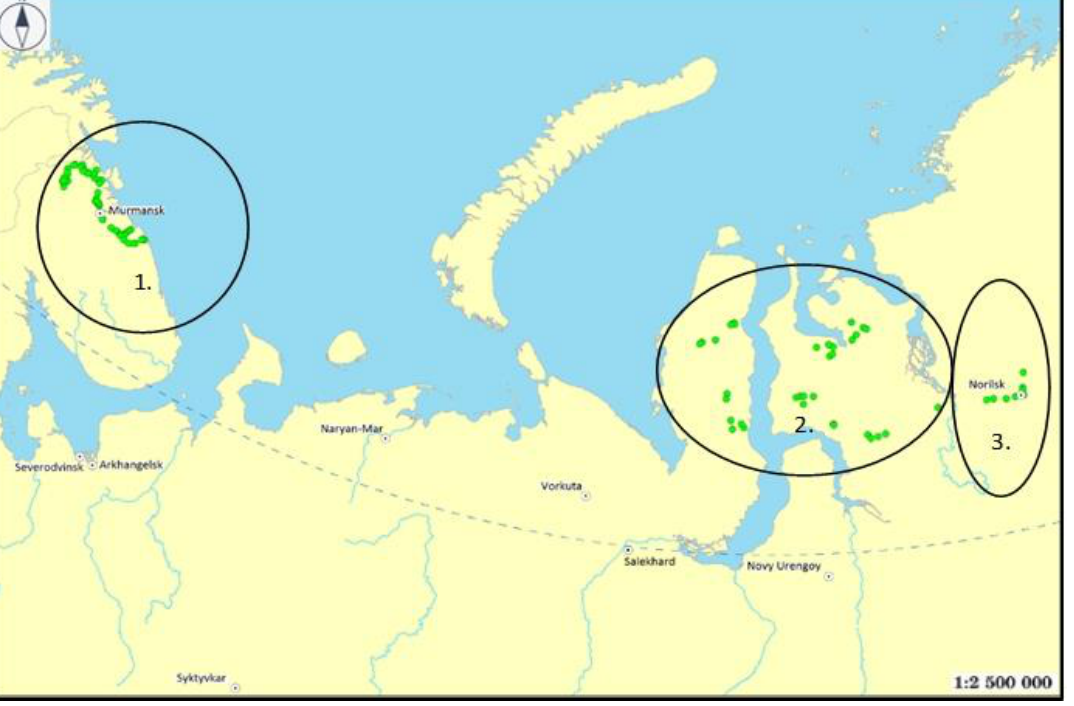
Figure 1. Regions of investigation and sampling points: Northern part of Euro-Asian territory of Russia. The dotted line is the border of the Arctic Circle. Points indicate selected lakes. 1—European Russia, 2—Western Siberia, 3—Eastern Siberia.